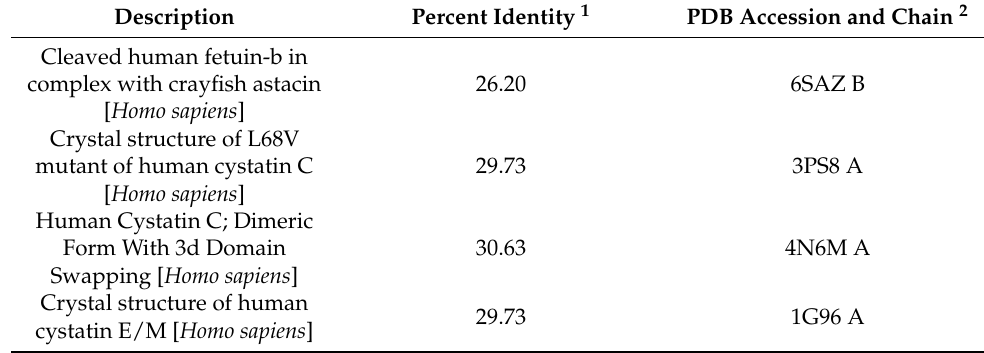
Table 1. Blastp results of human HK amino acid sequence against Protein Data Bank proteins.